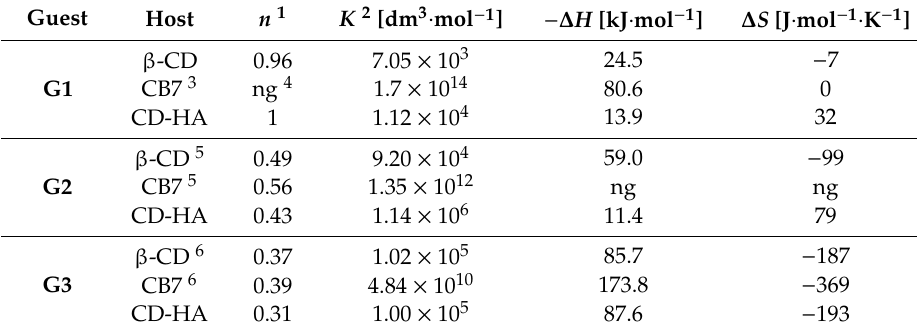
Table 1. Thermodynamic data for the guests G1 – G3 .